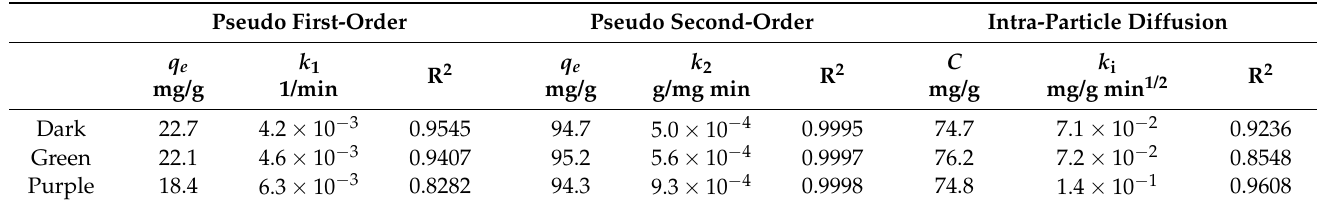
Table 4. Psuedo first-order, pseudo second-order, and intra-particle diffusion model parameters for removal of 60 mg/L of MB by TPNi under green light, purple light, and in the dark. Pseudo First-Order